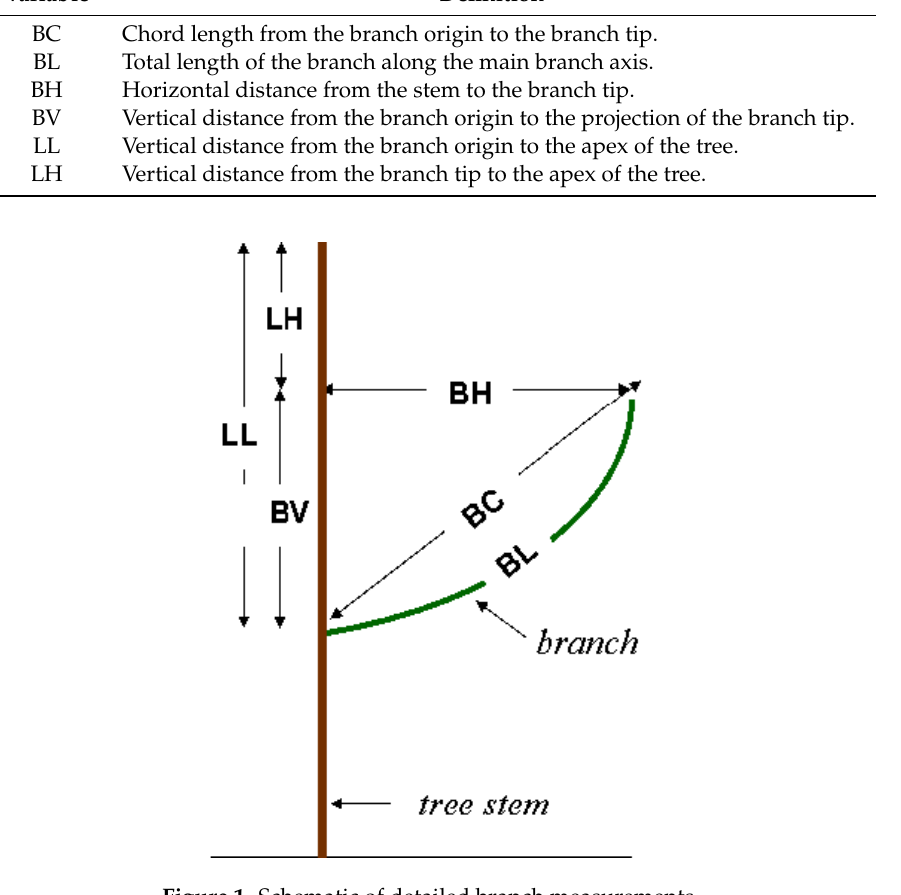
Figure 1. Schematic of detailed branch measurements.